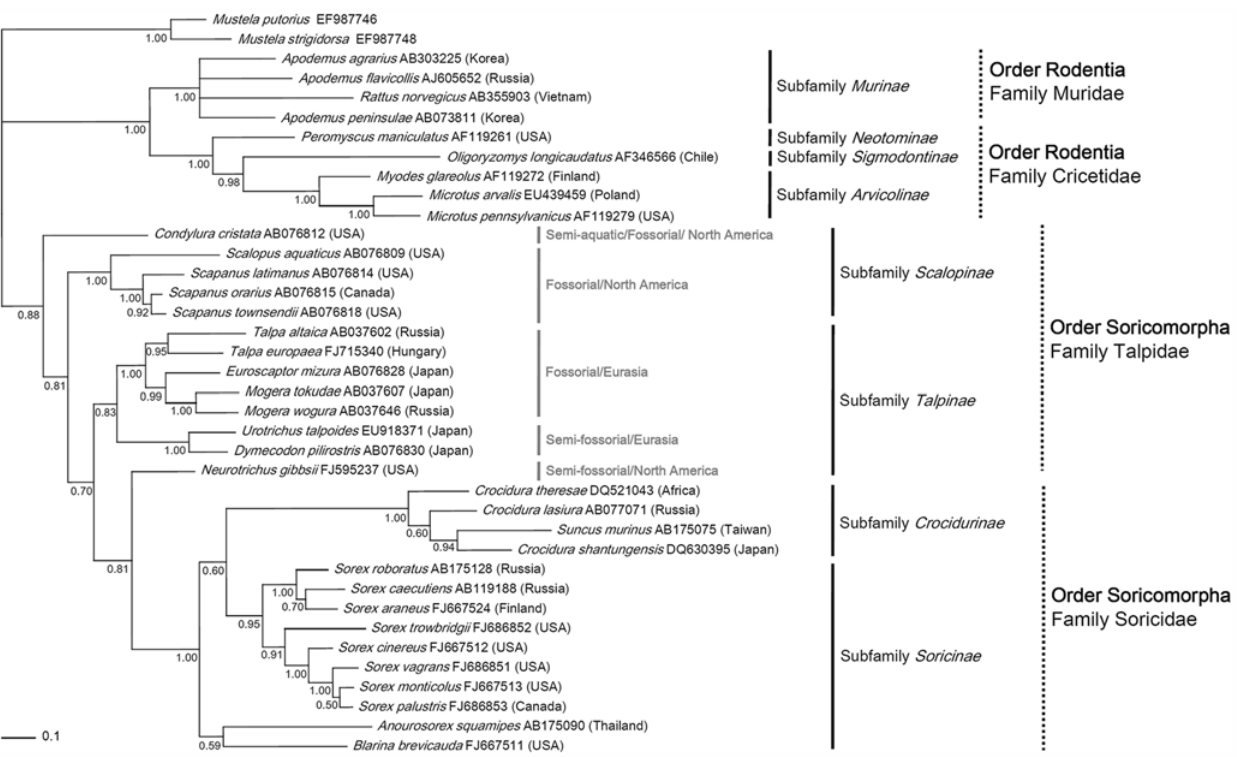
Figure 6. Maximum-likelihood phylogenetic trees, based on the 1,140-nucleotide cytochrome b region of mitochondrial DNA sequences of mammals in the Orders Rodentia and Soricomorpha. The phylogenetic position of the hantavirus-positive Talpa europaea (FJ715340) is shown in relationship to other Talpa europaea cytochrome b sequences from GenBank (AB037601, AB076829), as well as to other members of the Family Talpidae, as well as rodents and shrews. Mustela putorius (EF987746) and Mustela strigidorsa (EF987748) were used for the outgroup. The GenBank number and the country where each animal was captured are provided. Numbers at nodes are posterior node probabilities based on 30,000 trees: two replicate Markov Chain Monte Carlo runs consisting of four chains of two million generations each sampled every 100 generations with a burn-in of 5,000 (25%). The scale bar indicates nucleotide substitutions per site.